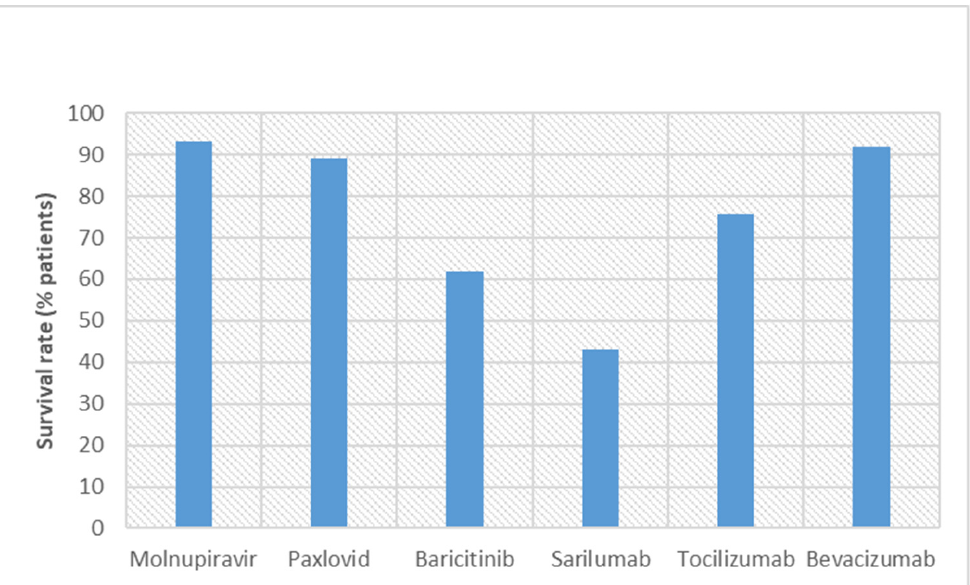
Figure 1. Comparison of the survival rates of COVID ‐ 19 patients in clinical trials conducted with new discovered molecules.